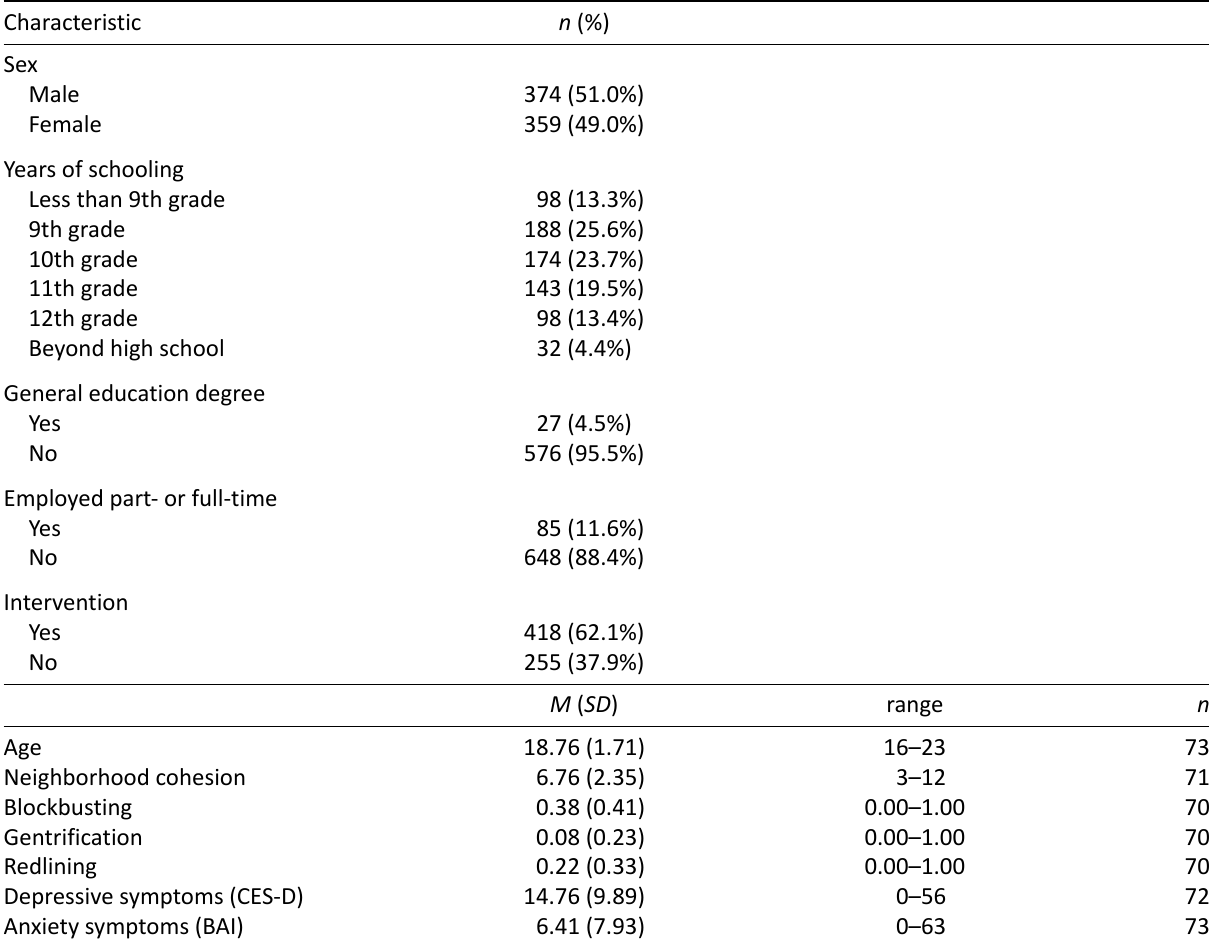
Table 1. Characteristics of the analytic